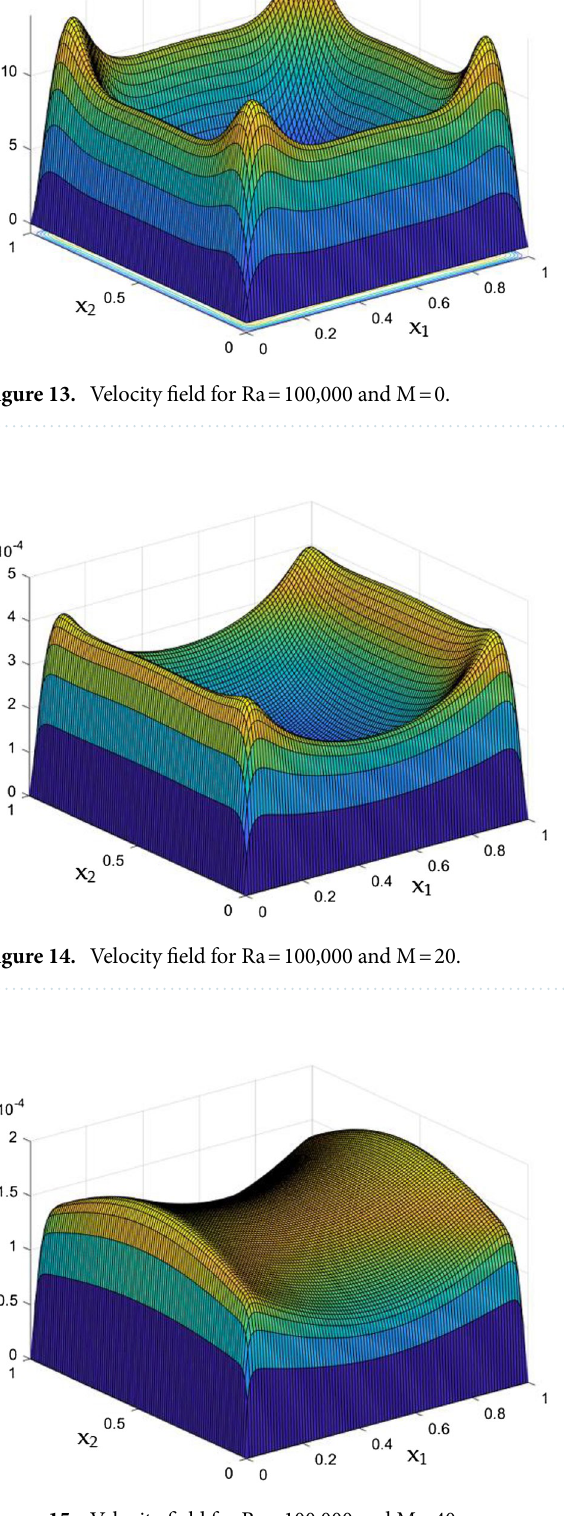
Figure 15. Velocity field for Ra = 100,000 and M =